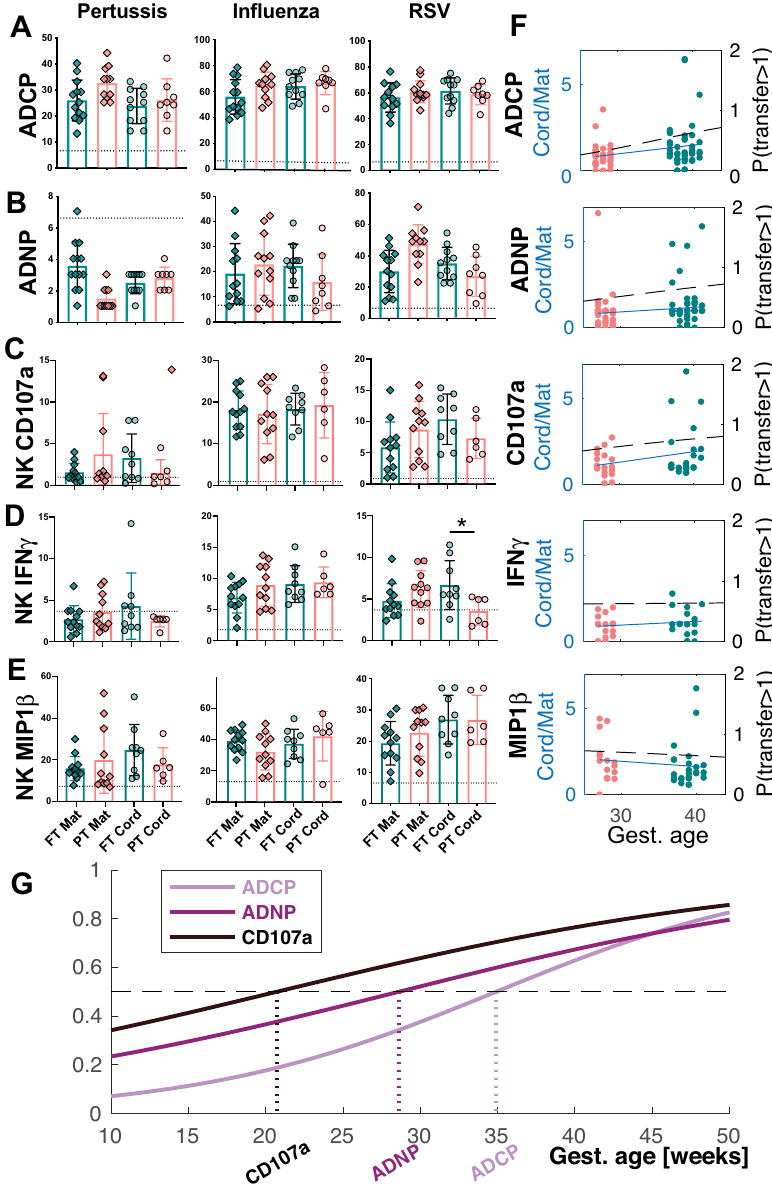
Figure 6. Functional antibodies transfer early in pregnancy. ( A–E ) The dot plots depict the univariate level of ( A ) ADCP, ( B ) ADNP, ( C ) antibody mediated NK cell degranulation (NK CD107a), ( D ) antibody driven NK cell IFNγ secretion, ( E ) antibody dependent NK cell chemokine MIP1β secretion across Pertussis-, Influenza-, and RSV-specific antigens. ( F ) The dot plots show the transfer ratios by gestational age, with each dot representing a different antigen and sample set organized by gestational groups (PT: pink and FT: green). Fewer antigens were included for the functional profiling due to sample limitations. Regression coefficients were estimated as 0.08, 0.10, 0.01, − 1.41, and 0.08 for ADCP, ADNP, NK MIP1β, IFNγ, and CD107a expression, respectively. Moreover, the likelihood of transfer ratios surpassing the likelihood of transfer ratio < 1 were calculated at gestational week 36, 41, 63, 36 and 24, respectively. ( G ) The individual probabilities for ADCP, ADNP, and NK CD107a were plotted and overlaid for comparison. The probability curves for NK IFNγ and MIP1β secretion were excluded since the fitted nominal multinomial logistic regression model was not reliably parameterized. The likelihood of transfer ratio ≥ 1 surpasses the likelihood of transfer ratio < 1 was marked on the graph with hatched